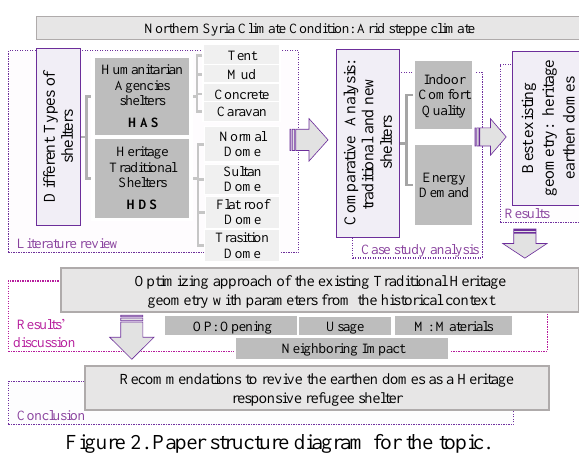
Figure 2. Paper structure diagram for the topic.